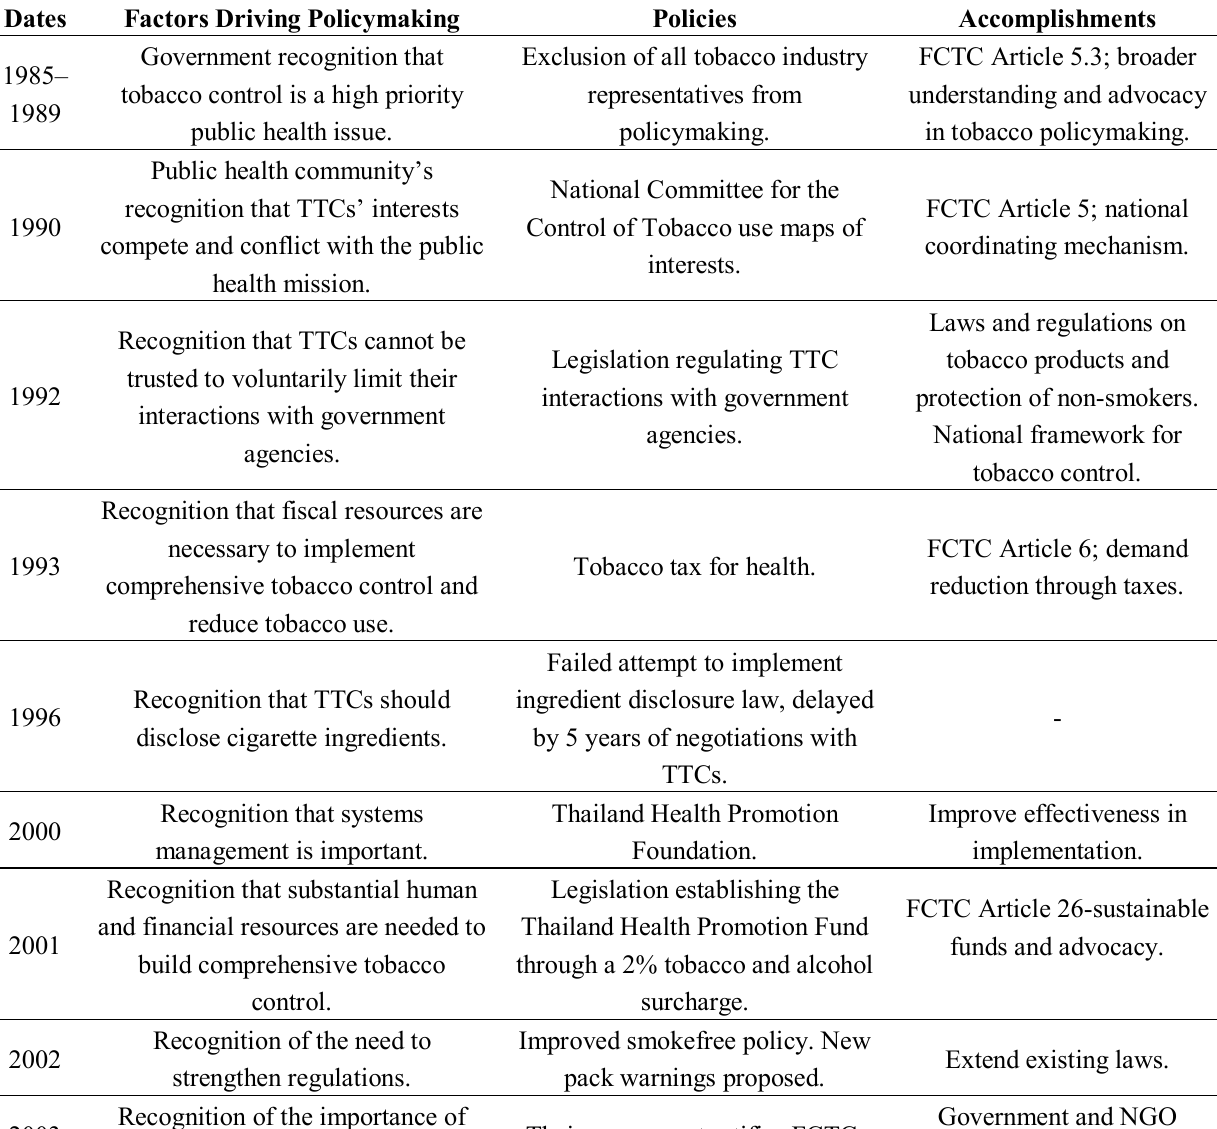
Table 1. Chronology of Thailand’s Efforts to Stop Transnational Tobacco Company